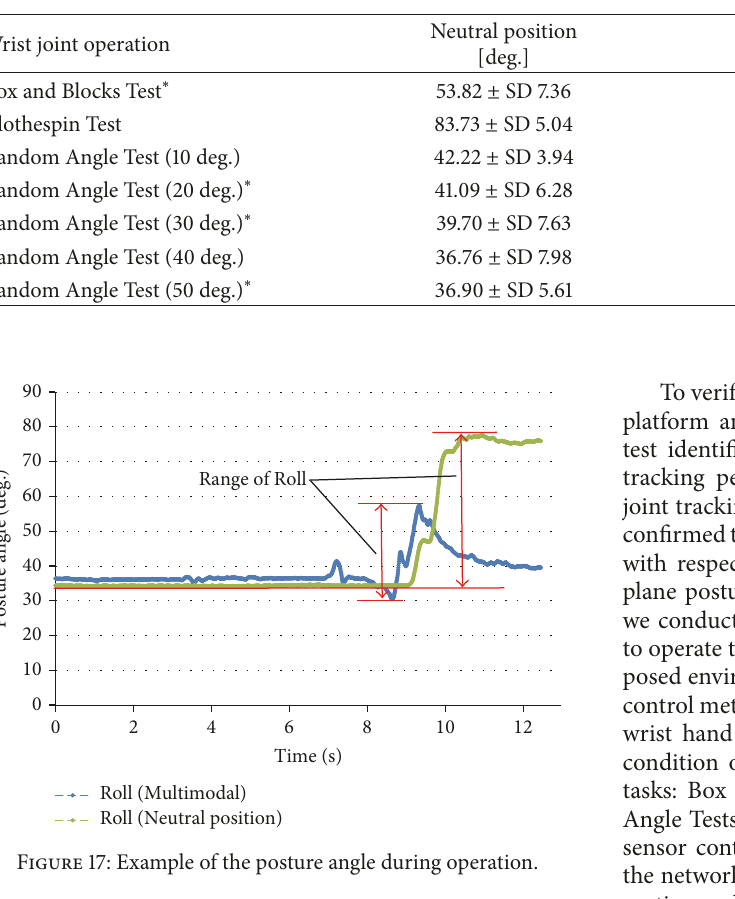
Table 5: Mean and average reduction rate of Range of Roll ( ∗ 𝑝 < 0.05 , 𝑁 = 4 ).